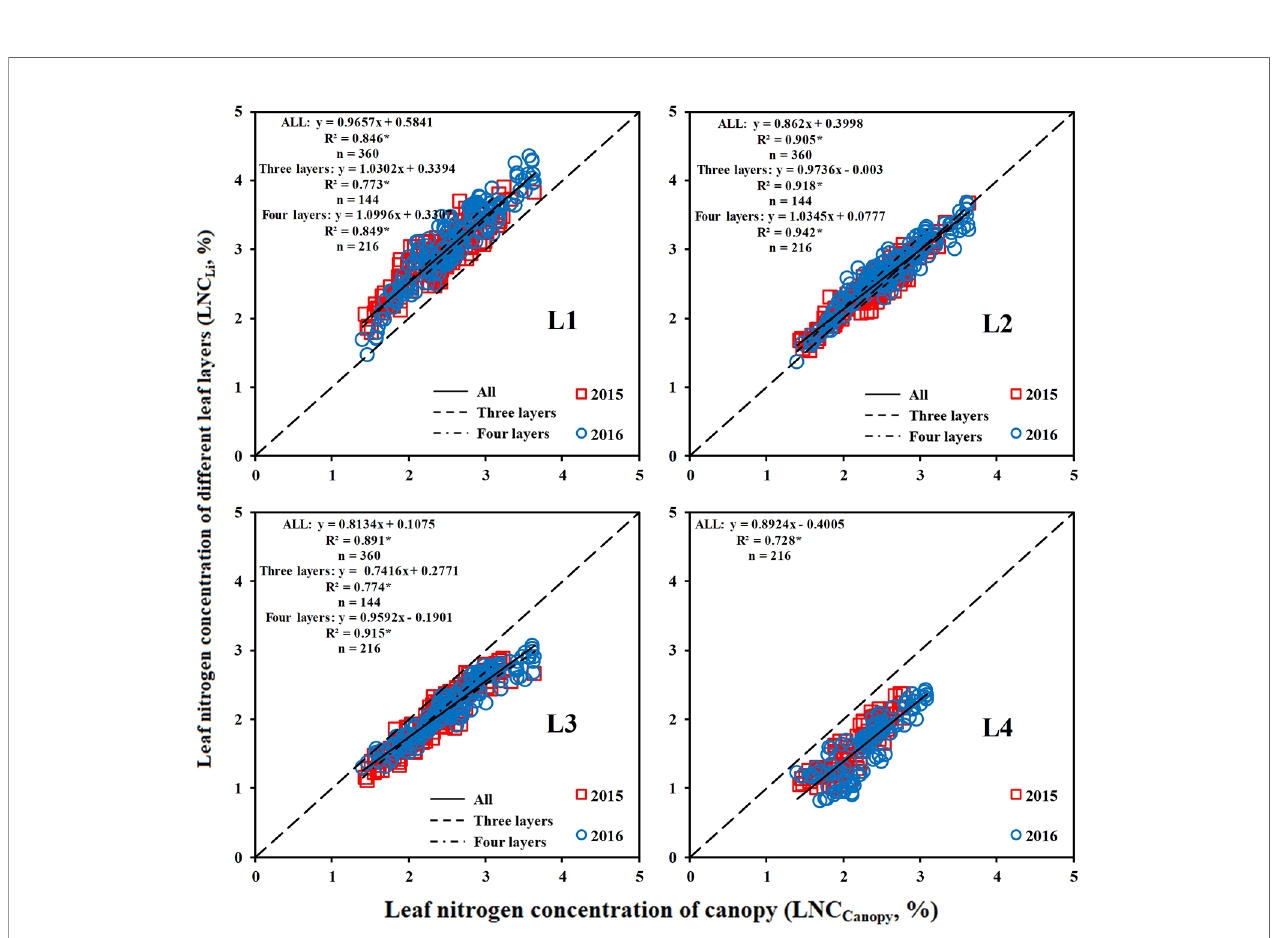
FIGURE 5 | Relationship between the LNC Li and LNC Canopy . * means accurate to